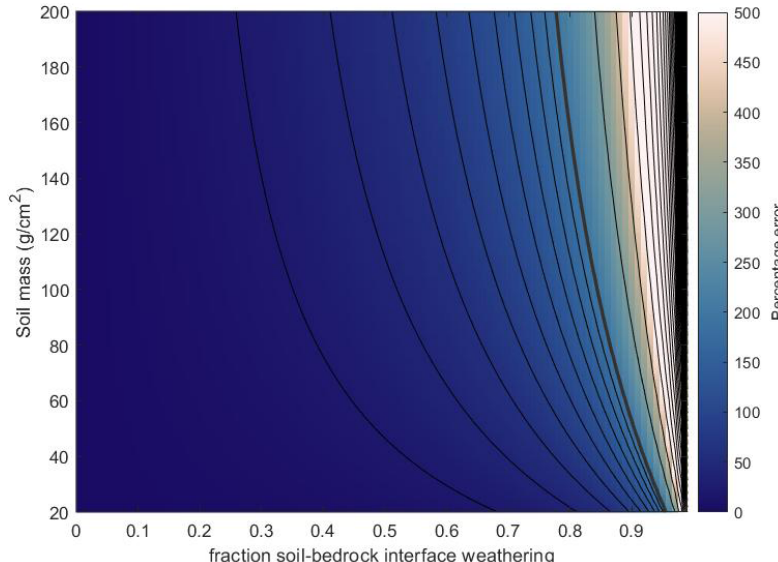
Figure 3. The percentage of CRN concentration increase due to weathering at the regolith–bedrock interface compared to a no-weathering scenario. The percentage of CRN increase is plotted for different fractions of regolith–bedrock weathering with respect to denudation and different regolith masses. Contour lines every 20%; above 200% (thick line) the contours are every